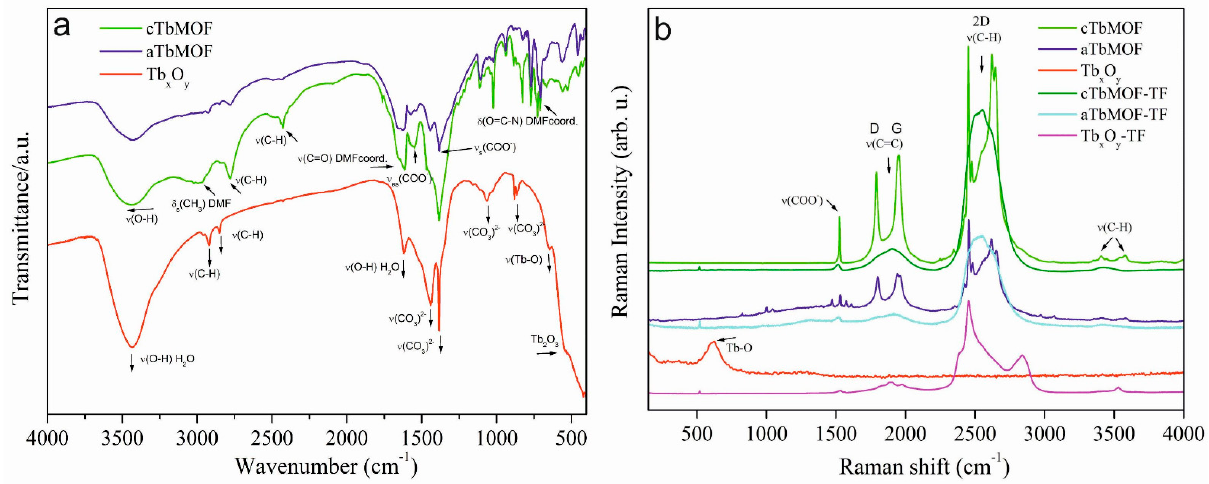
Figure 1. ( a ) FTIR and ( b ) Raman spectra of crystalline (cTbMOF), amorphous (aTbMOF),